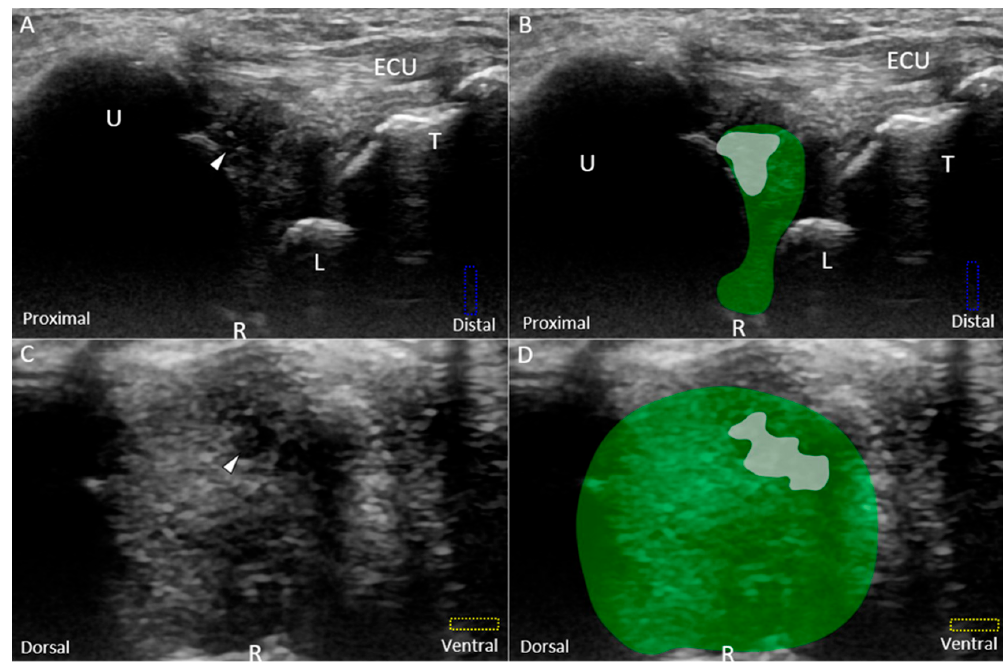
Figure 9. ( A ) US and ( B ) superposed US images using the long ‐ axis approach show a tear (white arrowhead and grey shade) of the disc (green shade) near the ulnar attachment, indicating Class 1B triangular fibrocartilage complex injury. ( C ) US and ( D ) superposed US images using the short ‐ axis approach show a hypoechoic lesion in the disc as well. The different color dashed rectangles are in accordance with the transducer positions in Figure 3. US: ultrasound; U: ulna; R: radius; L: lunate; T: triquetrum; SP: styloid process; ECU, extensor carpi ulnaris.